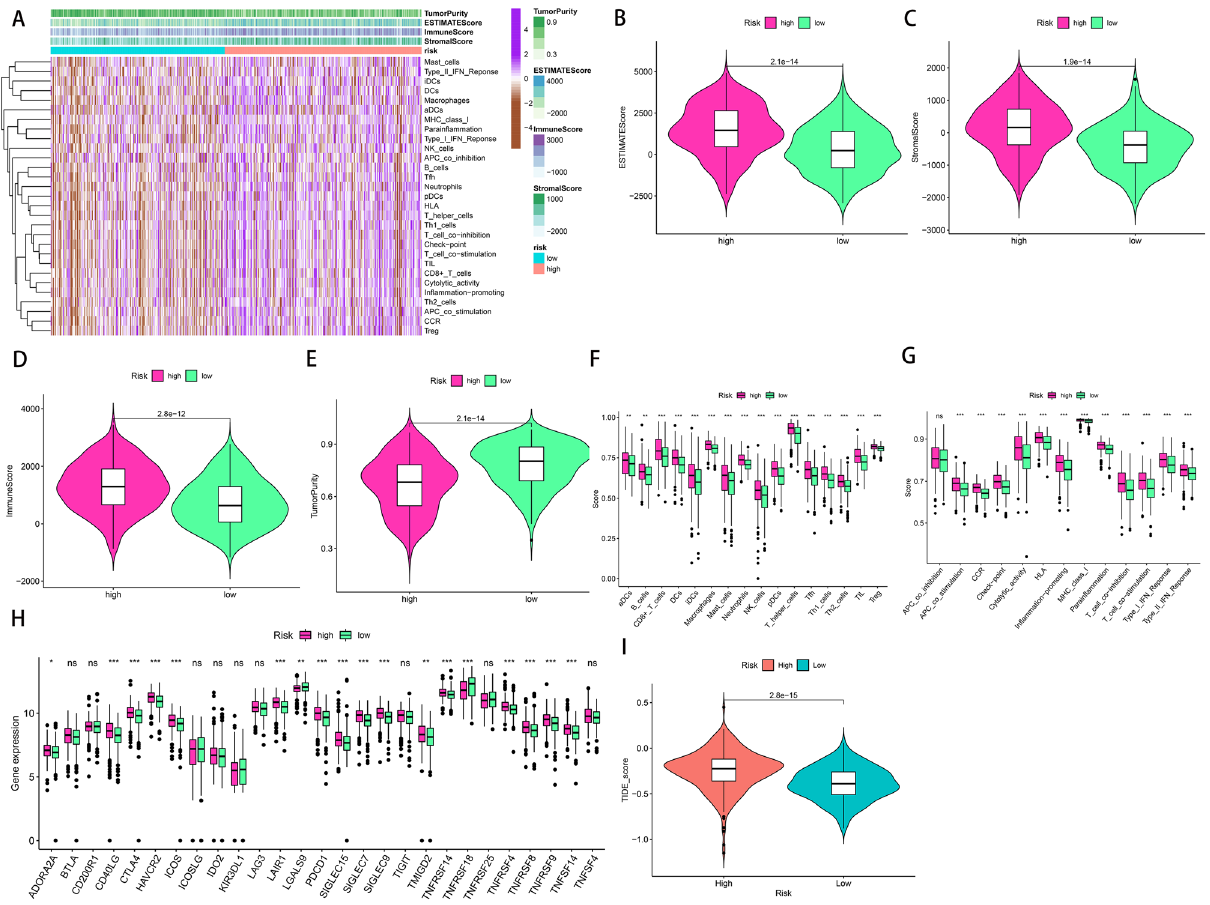
Figure 9. Estimation of the immune status and response to immunotherapy based on the signature in the high- risk and low-risk groups. ( A ) Heatmap of immune cell infiltration. ( B–E ) Violin plots for the immune score, stromal score, ESTIMATE score, and tumor purity. ( F–H ) Boxplots of immune cells score, immune-related functions score and immune checkpoints expression. ( I ) Prediction of immunotherapy response according to TIDE score. ESTIMATE estimation of stromal and immune cells in malignant tumour tissues using expression data, TIDE tumor immune dysfunction and exclusion. *P < 0.05, **P < 0.01, ***P < 0.001.